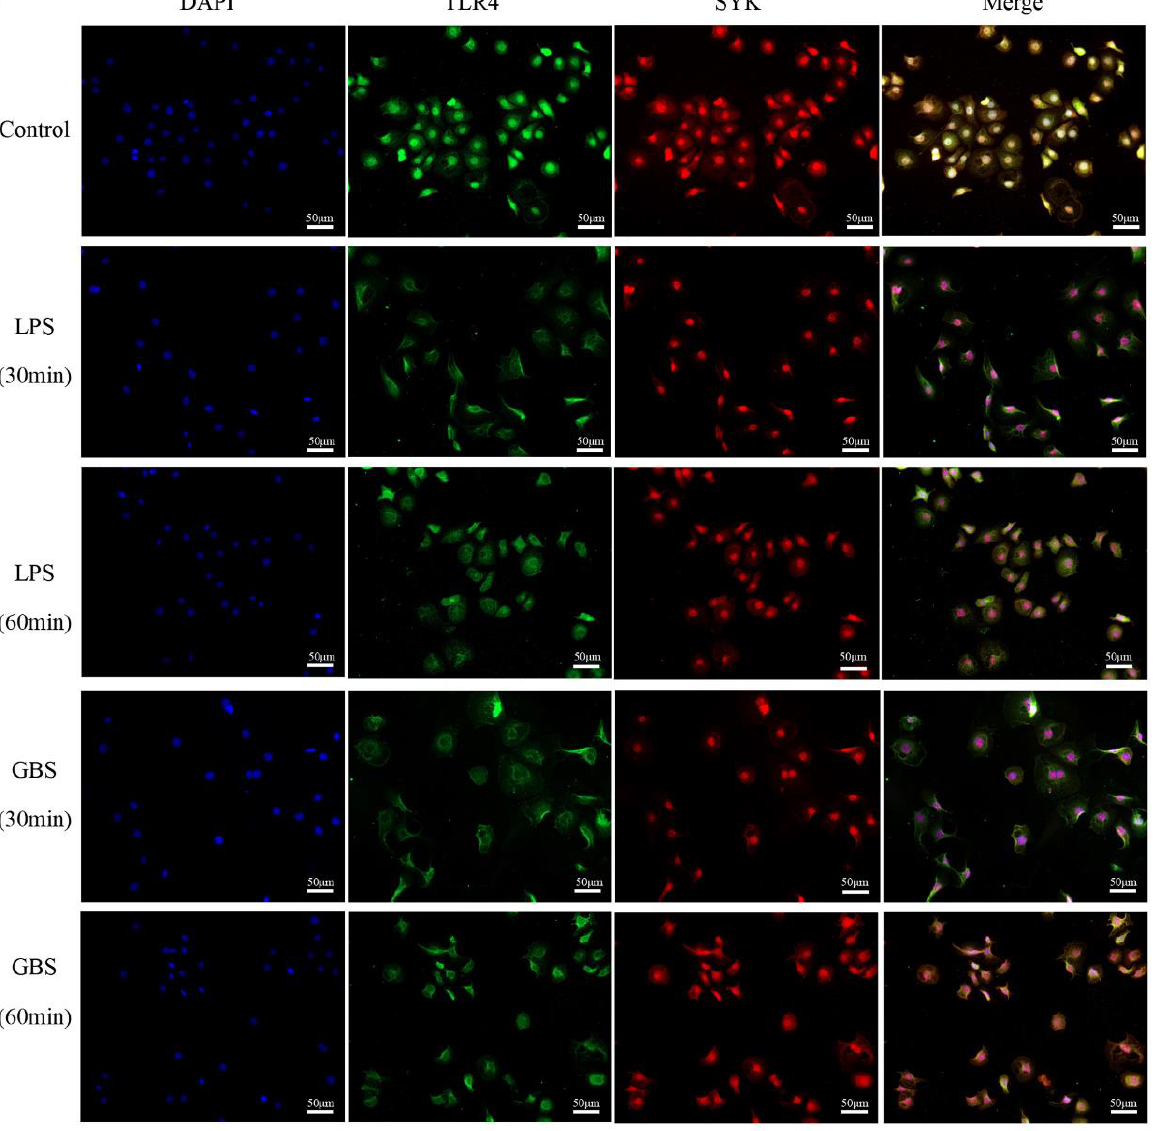
Figure 4. Immunofluorescence colocalization analyses of TLR4 and SYK in bMECs with LPS stimulation or GBS infection.